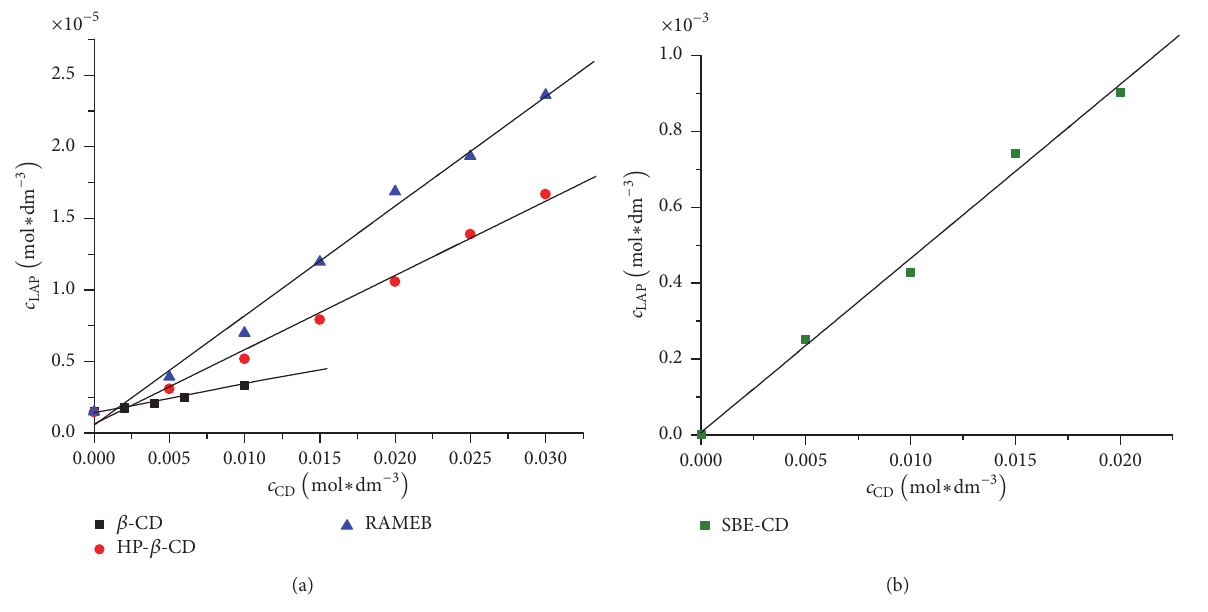
Figure 6: Phase-solubility diagrams of LAP-CD